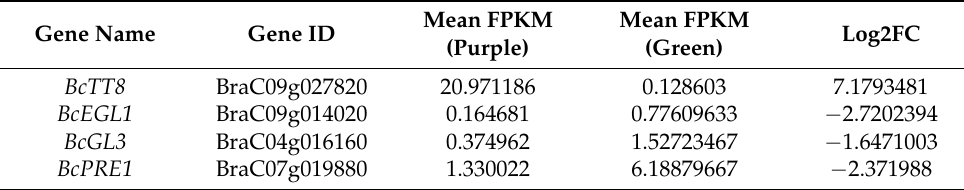
Figure 1. The volcano map tells us the expression trends of these DEGs between green and purple samples; the red dots and green dots present the upregulation and downregulation of DEGs, respectively, while the black dots mean genes without a significant difference in expression between the two samples. Table 1. DEGs of bHLH Gene Family.